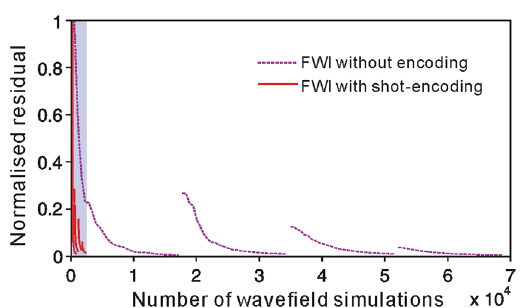
Figure 5. Number of wavefield simulations. Convergence rates of FWI without shot-encoding (purple dashed lines) and of shot-encoded FWI using the restarted L-BFGS algorithm (red solid lines within the shadowed zone). The horizontal axis denotes the number of wavefield simulations, and the vertical axis is the normalised residual. Each line segment corresponds to an inversion of a data set for a particular frequency